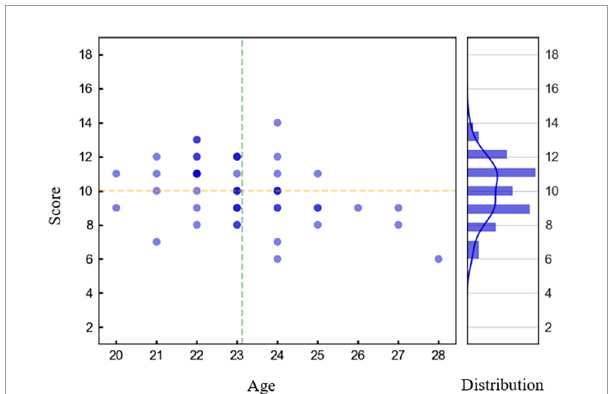
FIGURE5 Distribution of basic cognitive capacity test scores on the y -axis with respect to age on the x -axis. The horizontal line represents the mean score, and the vertical line represents the mean age. The subgraph on the right shows the distribution of subjects in different fractional